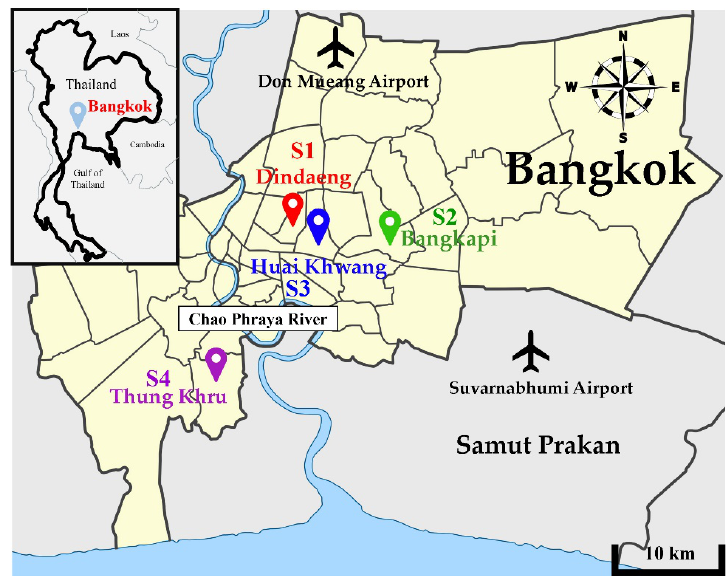
Figure 3. Sampling areas in Bangkok, Thailand for lead assays of drinking water samples. Table 2. Assay of lead contents in drinking water samples from different districts in Bangkok.